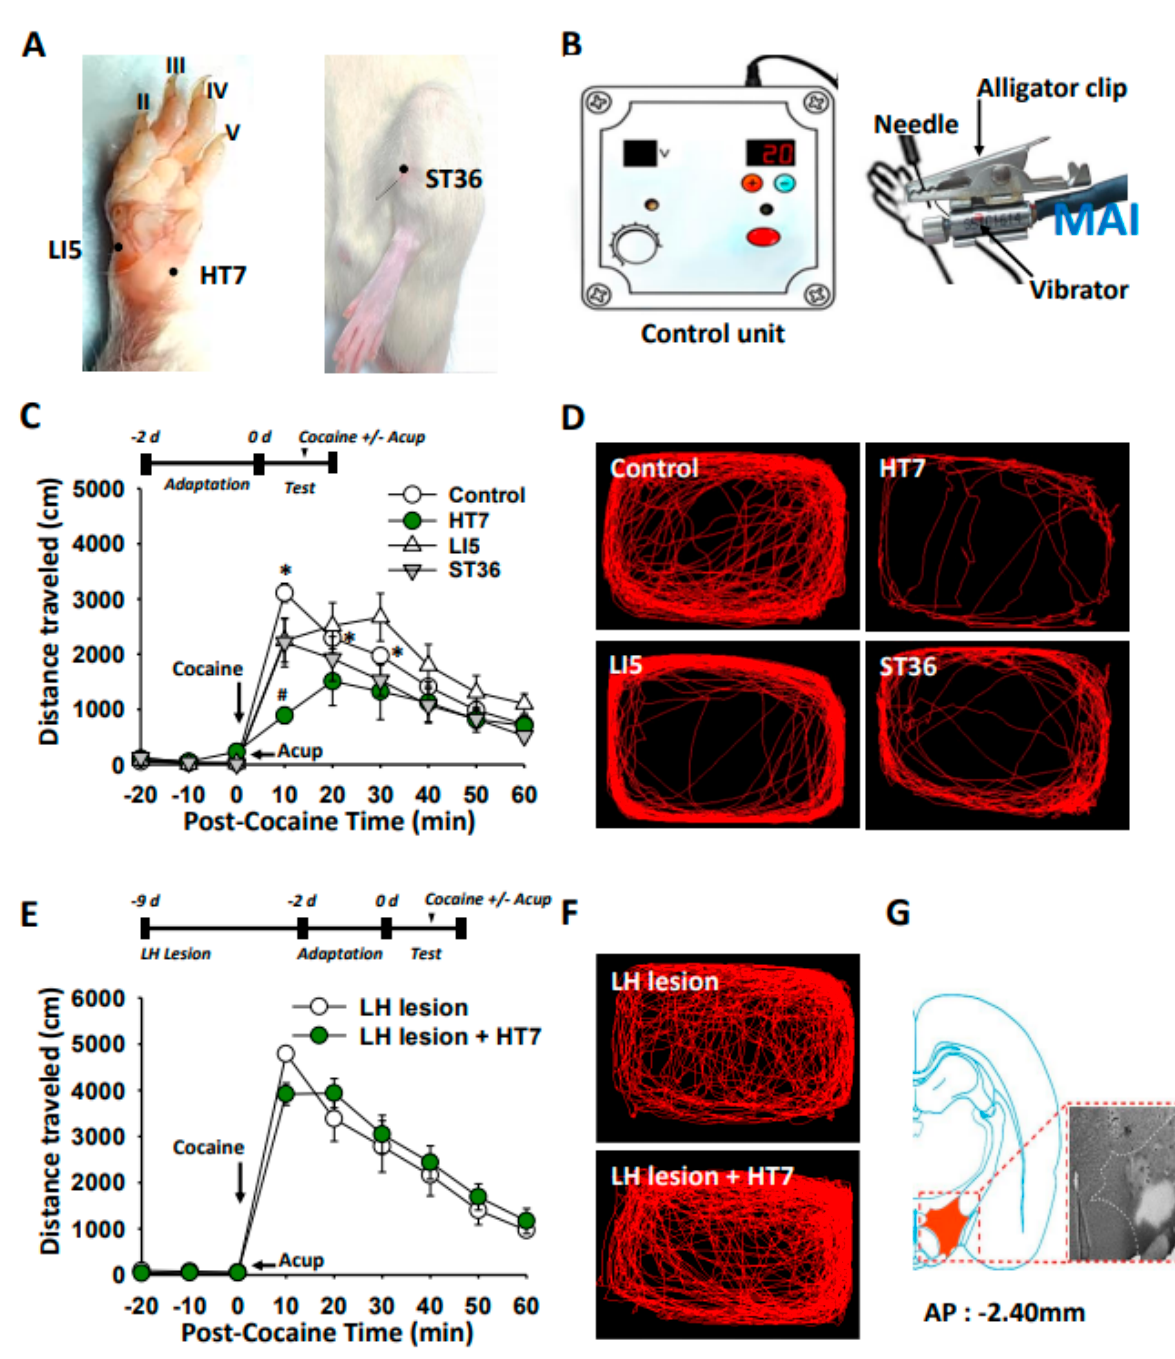
Figure 1. Effect of LH chemical lesions on acupuncture inhibition of cocaine-induced locomotor activity. ( A ) Schematic locations of the acupoints, HT7 and ST36, LI5. ( B ) Acupoints were stimulated with mechanical acupuncture instrument (MAI). ( C , D ) Effects of acupuncture on cocaine-induced enhancement of locomotor activity in rats. Rats received one acupuncture treatment for 20 s by using MAI. Acupuncture at HT7 ( n = 6), but neither ST36 ( n = 5) nor LI5 ( n = 6), reduced the mean distance traveled per 10 min following cocaine injection, compared to Control group (cocaine injection only, n = 6; C ). * p < 0.05 vs. the values before cocaine injection; # p < 0.05 vs. Control. Representative moving traces for 60 min after cocaine injection ( D ). ( E – G ) Effect of acupuncture on cocaine-induced locomotor activities in LH-lesioned rats. Representative moving traces for 60 min following cocaine injection in LH-lesioned rats ( F ). Toluidine blue-stained coronal sections of a rat brain with chemical lesions in the LH ( G ). LH lesion, cocaine injection in LH-lesioned rats ( n = 6); LH lesion + HT7, acupuncture at HT7 after cocaine injection in LH-lesioned rats ( n = 5). LH, lateral hypothalamus; Acup, acupuncture.